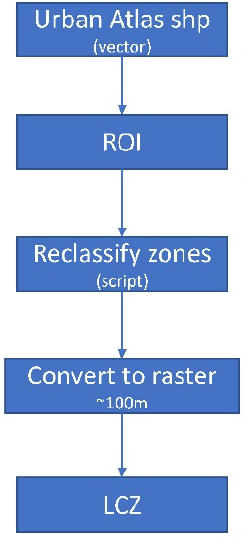
Figure 5. Workflow of the UA/GIS method.